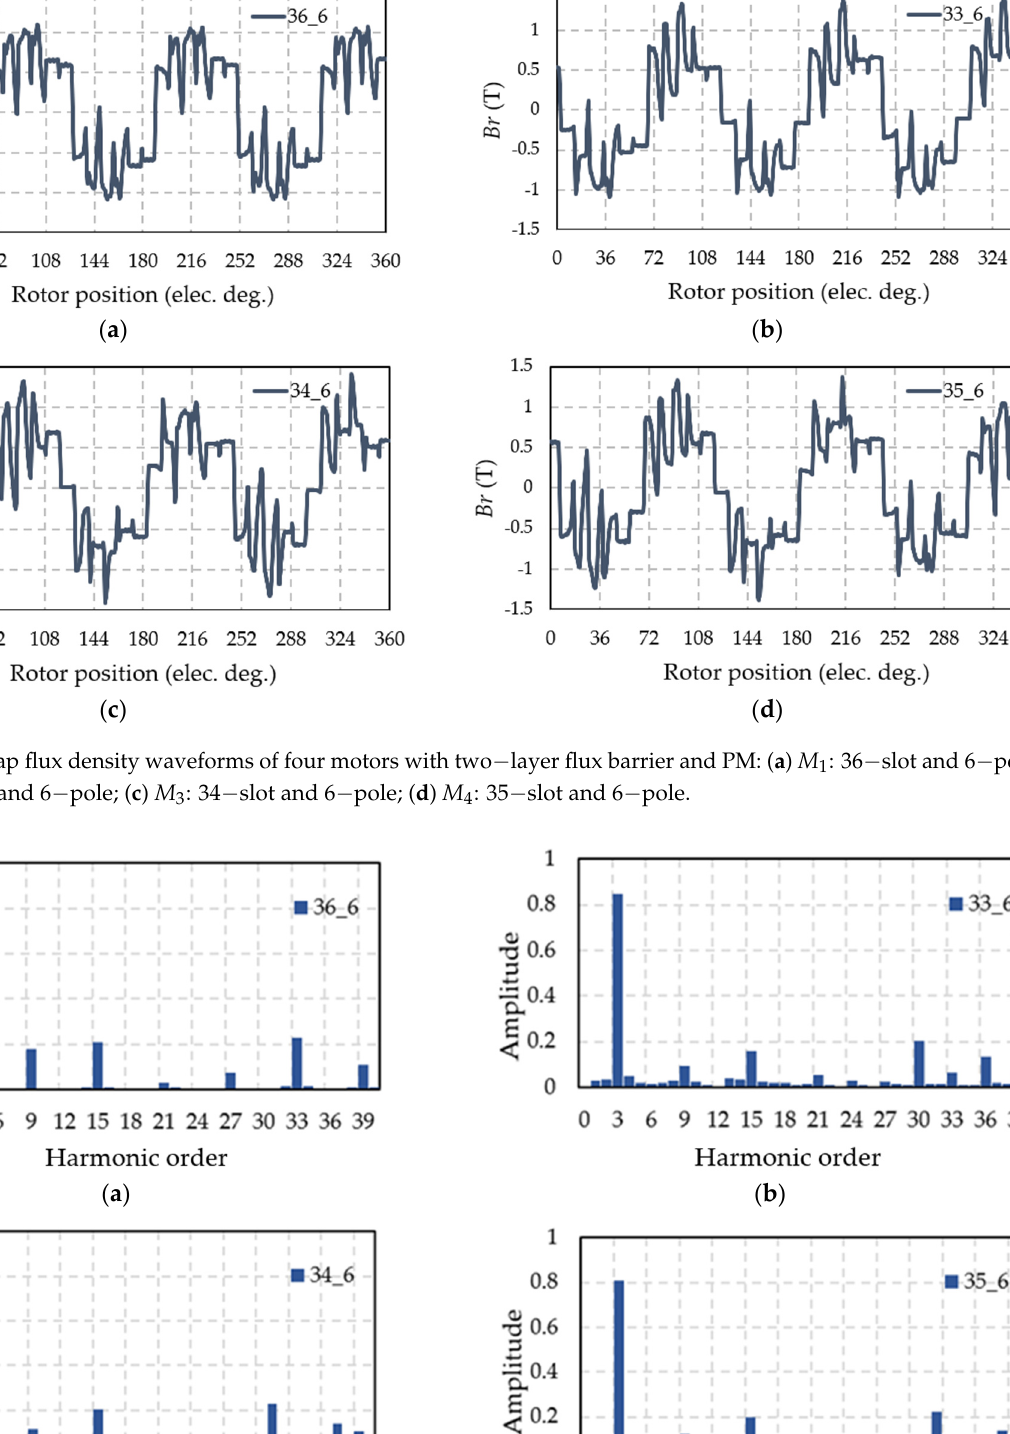
Figure 6. Air − gap flux density harmonics of four motors without flux barrier: ( a ) M 1 : 36 − slot and 6 − pole; ( b ) M 2 : 33 − slot and